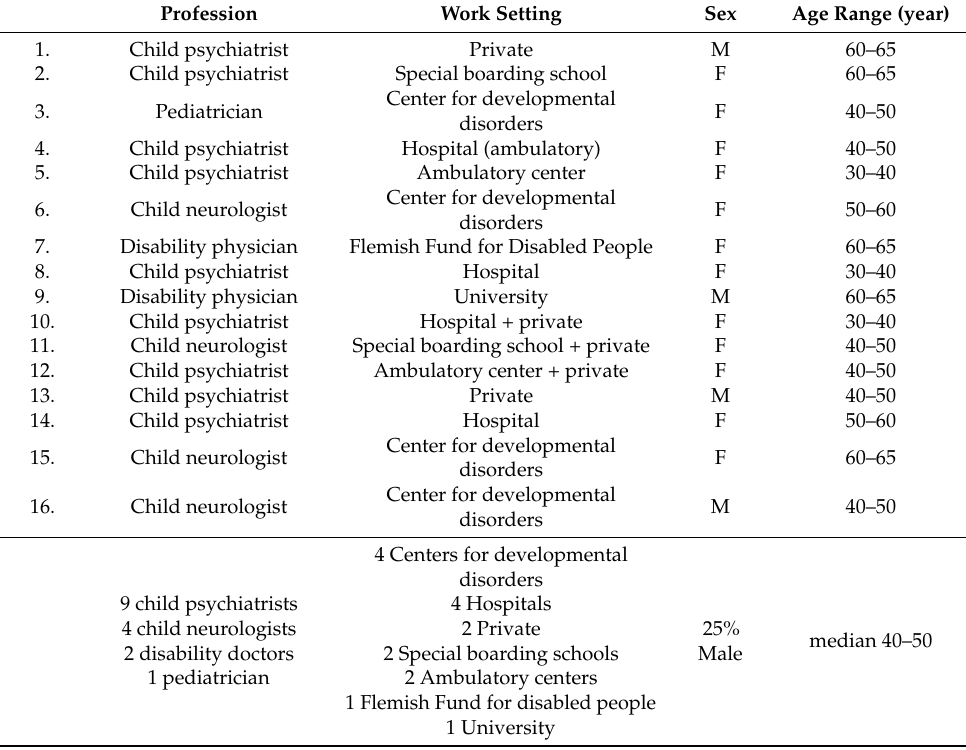
Table 1. Demographic and professional characteristics of study